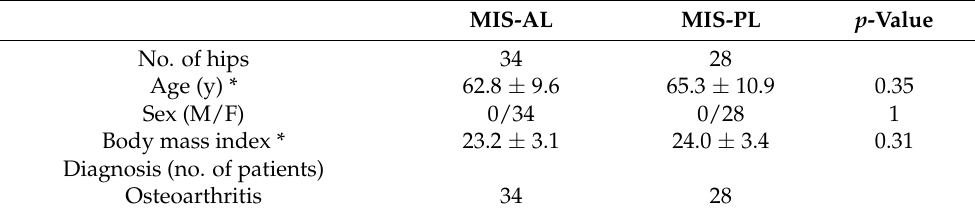
Table 1. Patient demographic data according to MIS-AL or MIS-PL minimally invasive THA